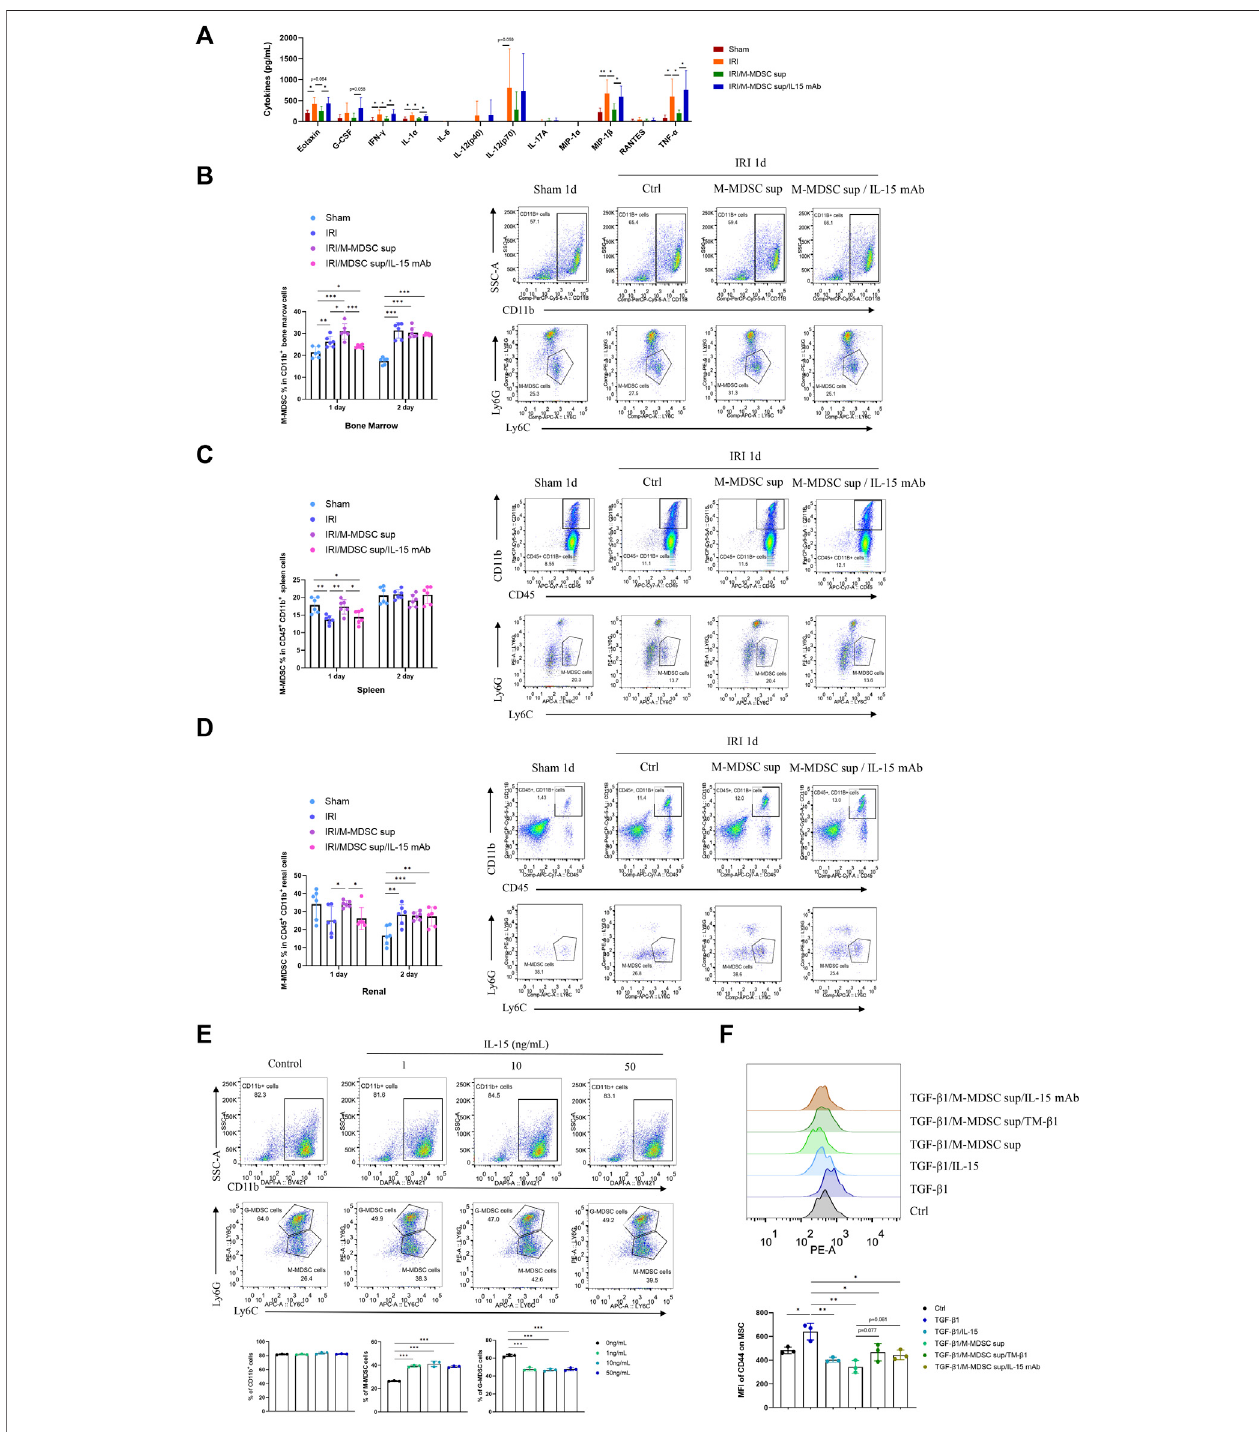
FIGURE 6 | M-MDSC supernatant attenuated systemic in fl ammation in renal fi brosis by promoting M-MDSCs in the BM, spleen and kidney via IL-15. (A) In fl ammatory cytokines in the serum of the murine renal IRI-induced fi brosis model were determined by Luminex analysis on Day 28 after the operation. (B) Detection of the proportion of CD11b + Ly6G − Ly6C high M-MDSCs in the bone marrow by fl ow cytometry on Days 1 and 2 after the operation. (C) Detection of the proportion of CD11b + Ly6G − Ly6C high M-MDSCs in the spleen by fl ow cytometry on Days 1 and 2 after the operation. (D) Detection of the proportion of CD11b + Ly6G − Ly6C high M-MDSCs in the kidney by fl ow cytometry on Days 1 and 2 after the operation. (E) Detection of CD11b + myeloid cells, CD11b + Ly6G − Ly6C high M-MDSCs, and CD11b + Ly6G + Ly6C low G-MDSCs in the bone marrow by fl ow cytometry after induction with IL-15 for 4 days. (F) Detection of the median fl uorescence intensity (MFI) of CD44 adhesion molecule expression on the surface of MSCs after induction with TGF- β 1 (5 ng/mL) for 24 h, with or without IL-15 (1 ng/mL), M-MDSC supernatant, IL- 15 mAb (10 μ g/mL) and TM- β 1 (10 ng/mL) for 2 days. * p < 0.05; ** p < 0.01; *** p < 0.001.